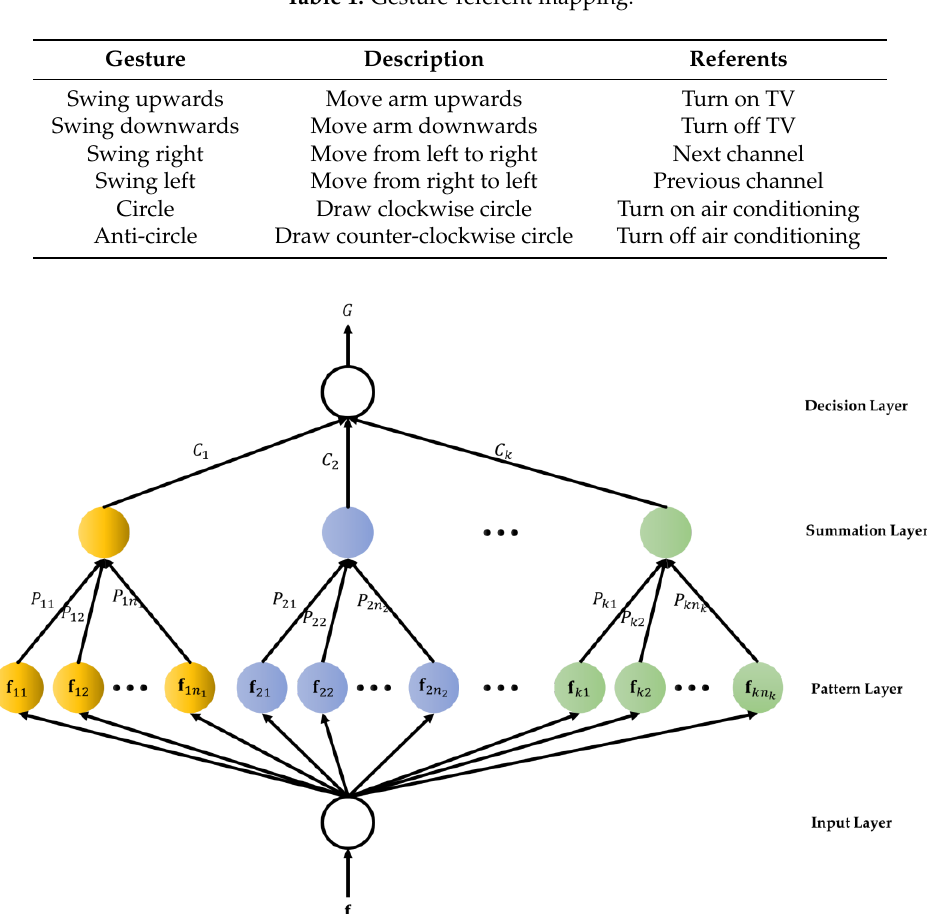
Figure 10. Structure of the probabilistic neural network recognizer.